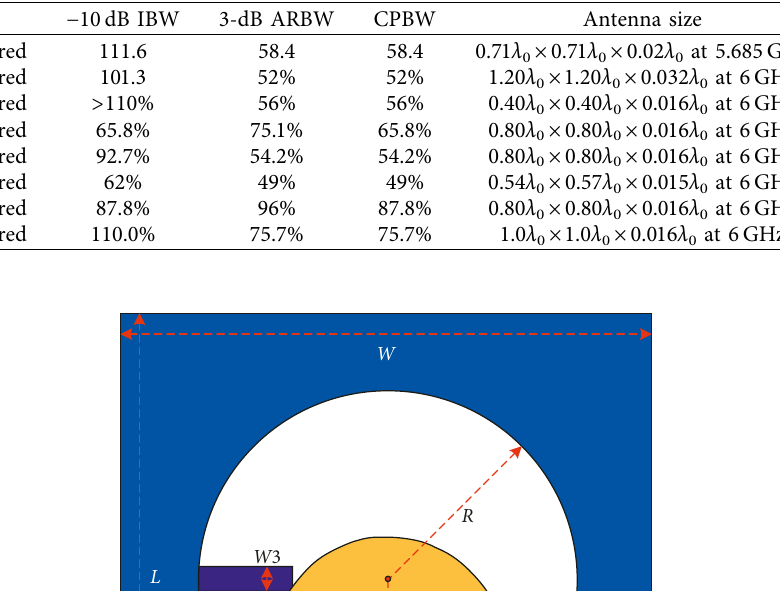
Table 1: Comparison of the proposed antenna to previously reported antennas.